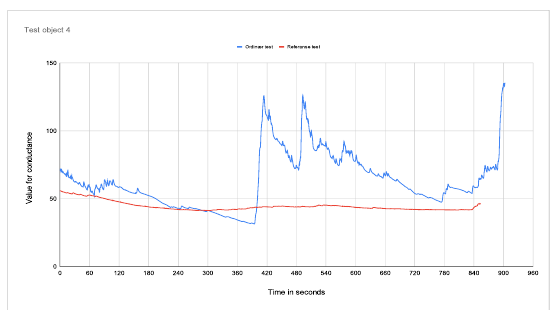
Figure 9: Plot of conductance for test subject 4 Percentage change with electrodes in palm: 76,81% Percentage change with electrodes on arm: